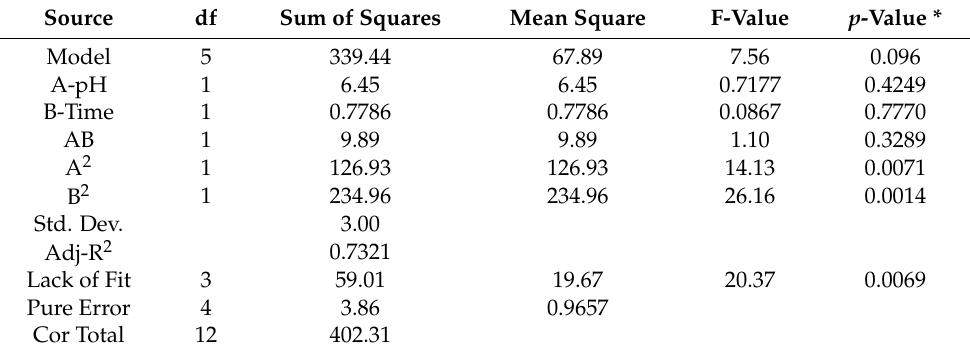
Table 4. ANOVA results for the response surface quadratic model